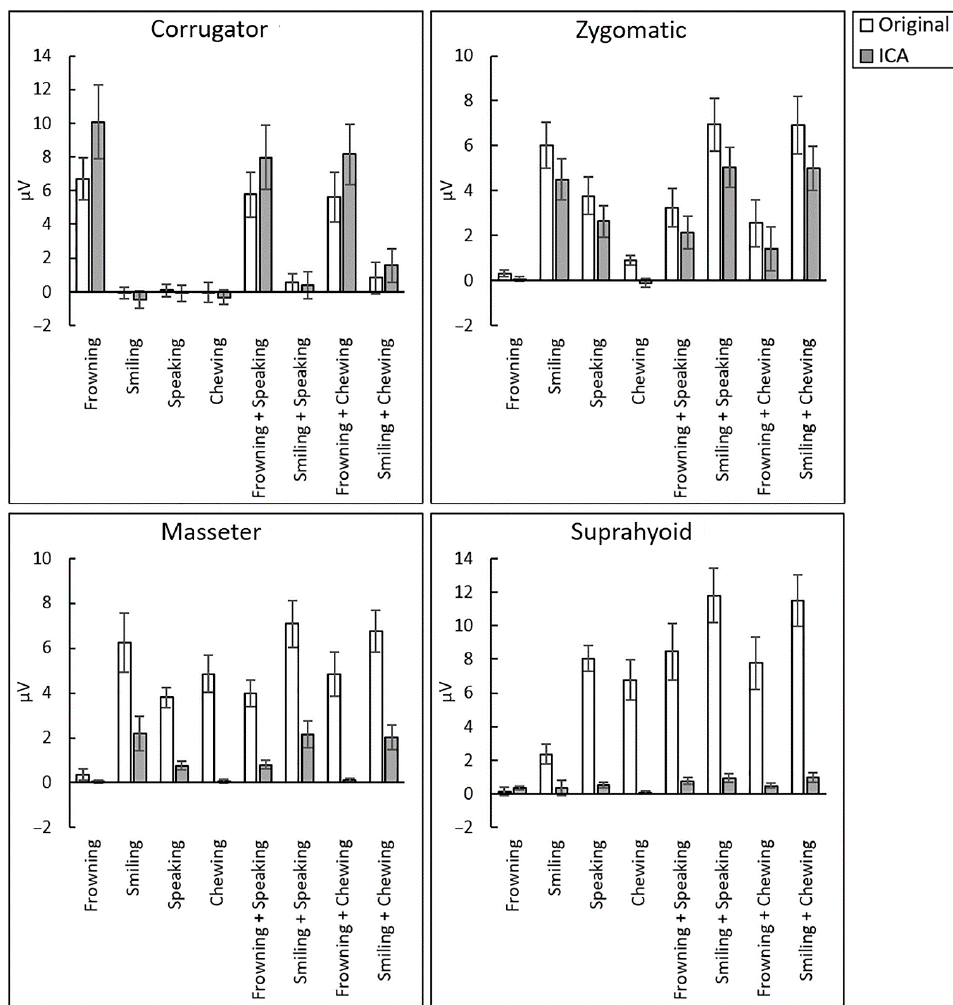
Figure 3. Mean ± standard error of original and independent component analysis (ICA)-reconstructed electromyography data recorded from the corrugator supercilii, zygomatic major, masseter, and suprahyoid muscles during frowning, smiling, chewing, speaking actions, and combinations of these actions. Table 1. Results of one-sample t -tests (vs. zero; two-tailed) of original electromyography signals. Facial Action